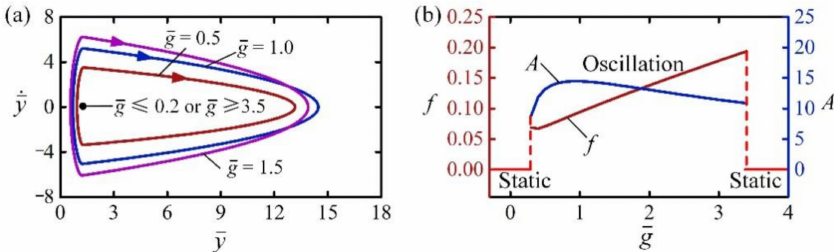
Figure 10. The effect of gravitational acceleration on the self-jumping for I 0 = 2, C 0 = 0.3, H = 4, . = 0.5, E = 500, y = 30, and = 0. ( a ) Limit cycles. ( b ) Frequency and y β = 0.01, n g = 200, p am 0 0 amplitude. With the increase of g , the frequency increases monotonically, while the amplitude first increases and then